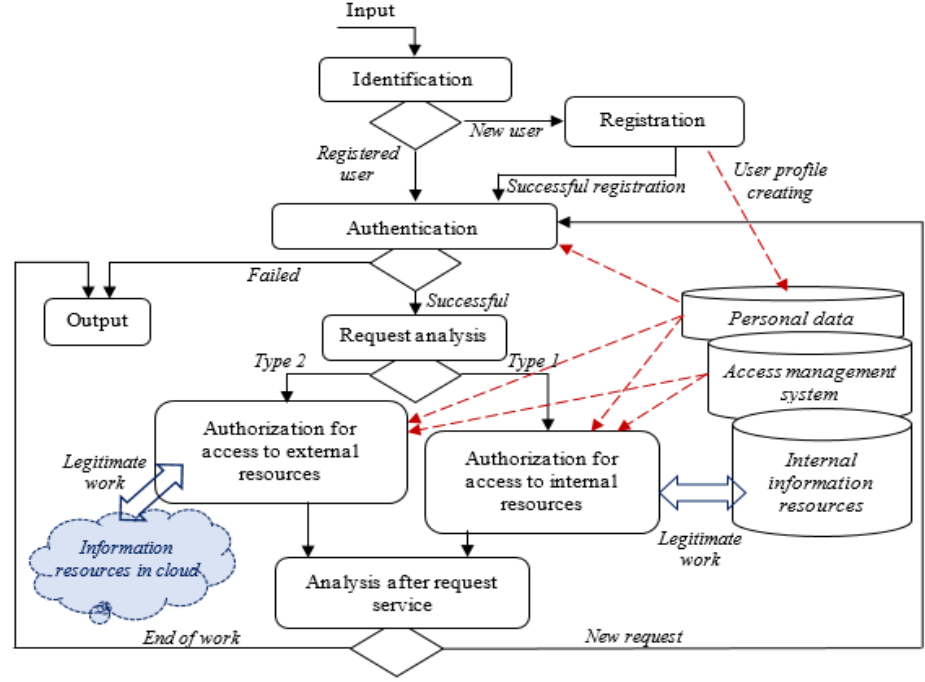
Figure 2. Formalization of processes for access regulation.